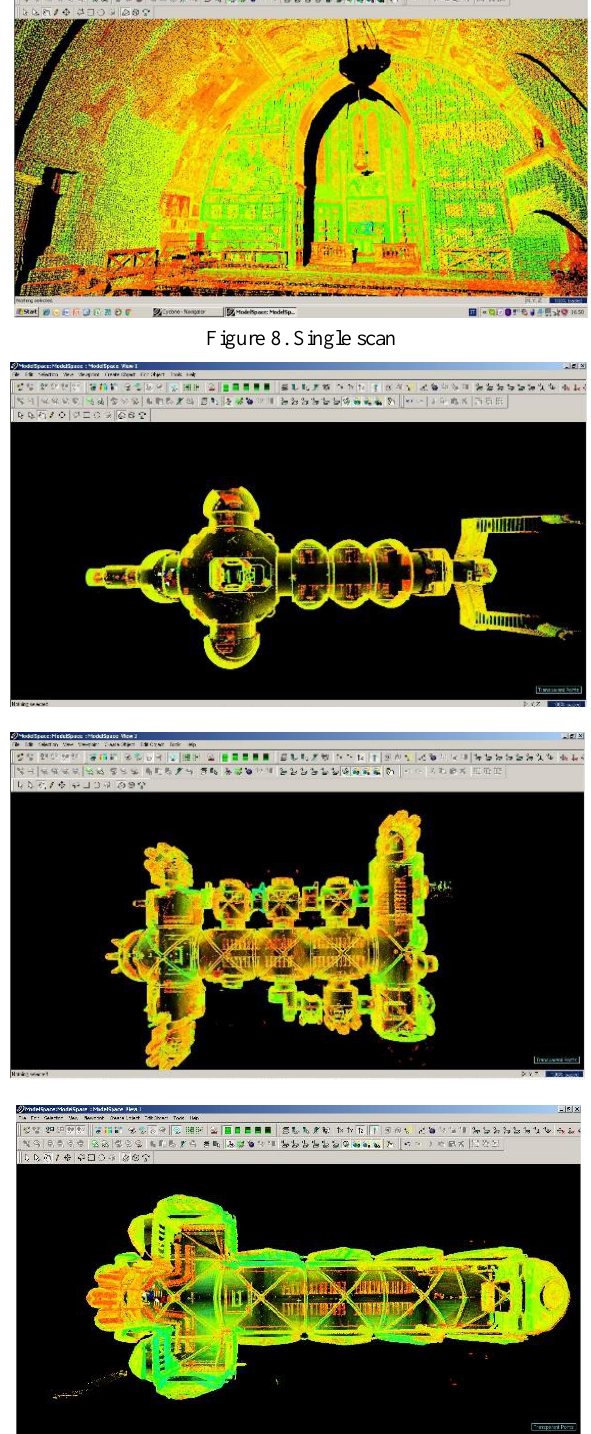
Figure 9. Point clouds of Crypt (upper figure), lower Basilica (medium figure) and upper Basilica (lower